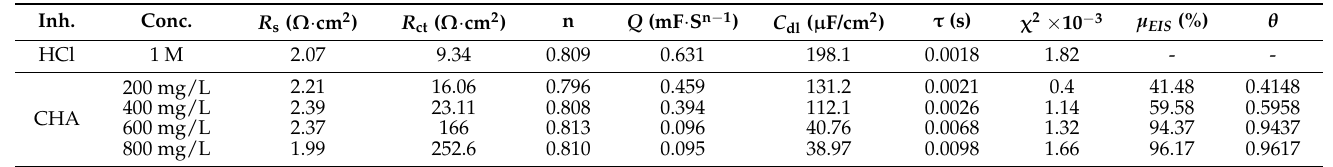
Table 3. Different values of electrochemical parameters extracted from EIS Nyquist curves without and with different molar content of CHA extract at 298